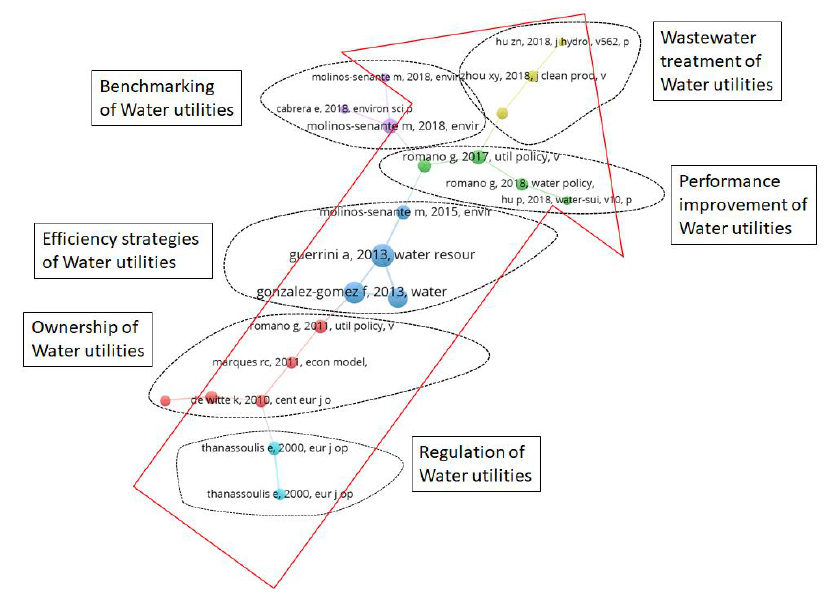
Figure 3. Main path suing the global key route.